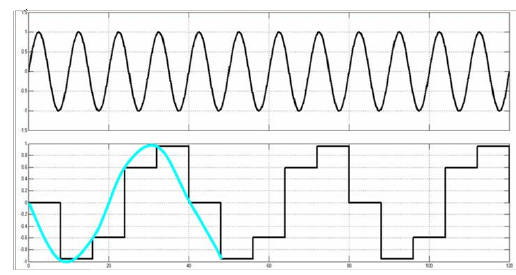
Fig. 8. The results of experiments at a maximum sampling frequency